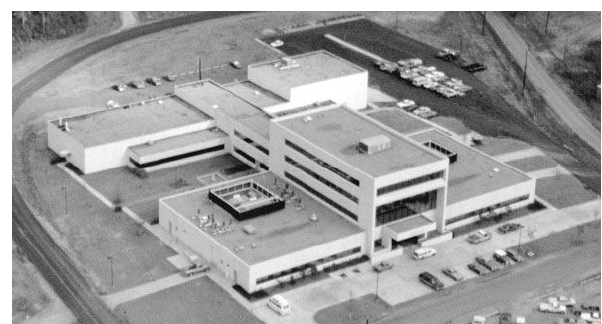
Figure 12. Arthur Casagrande Building. New WES facilities, Vicksburg,